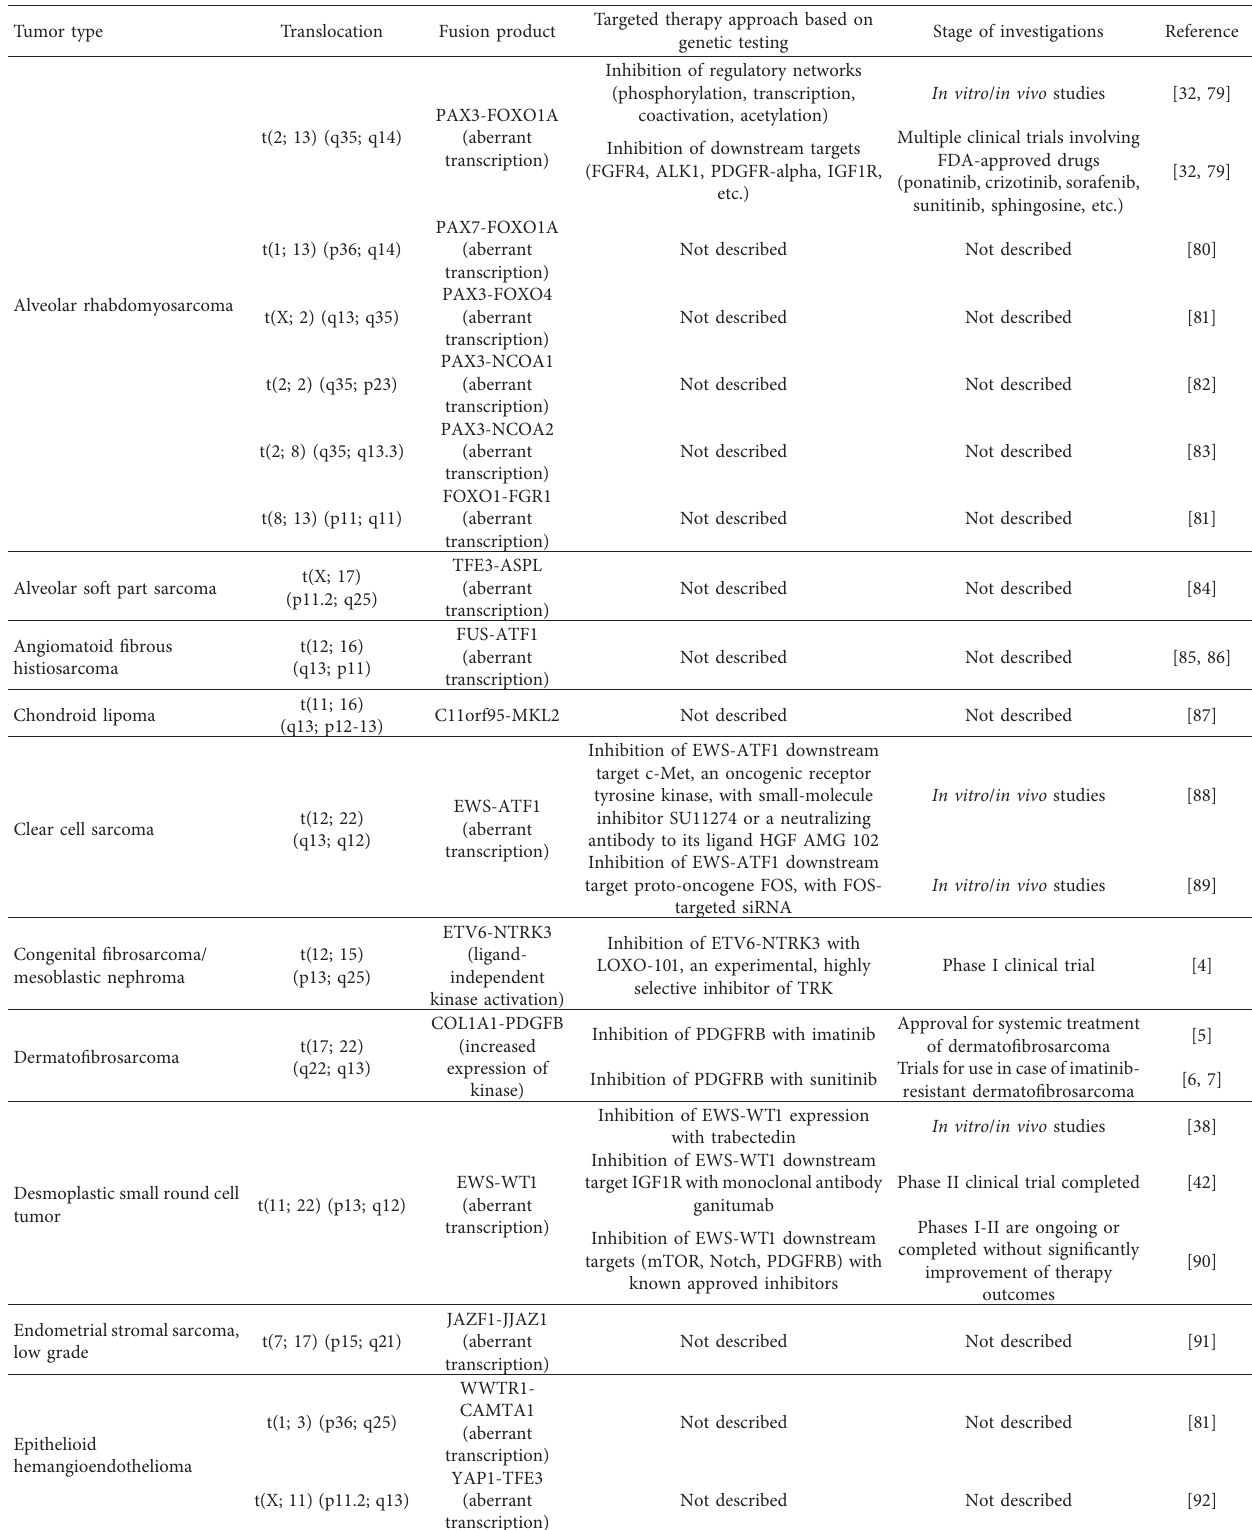
Table 1: Chromosomal translocations in